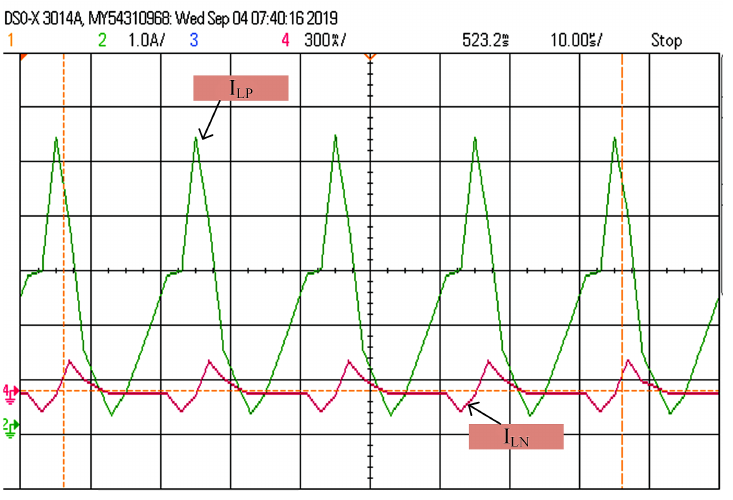
Figure 18. Inductor currents I L